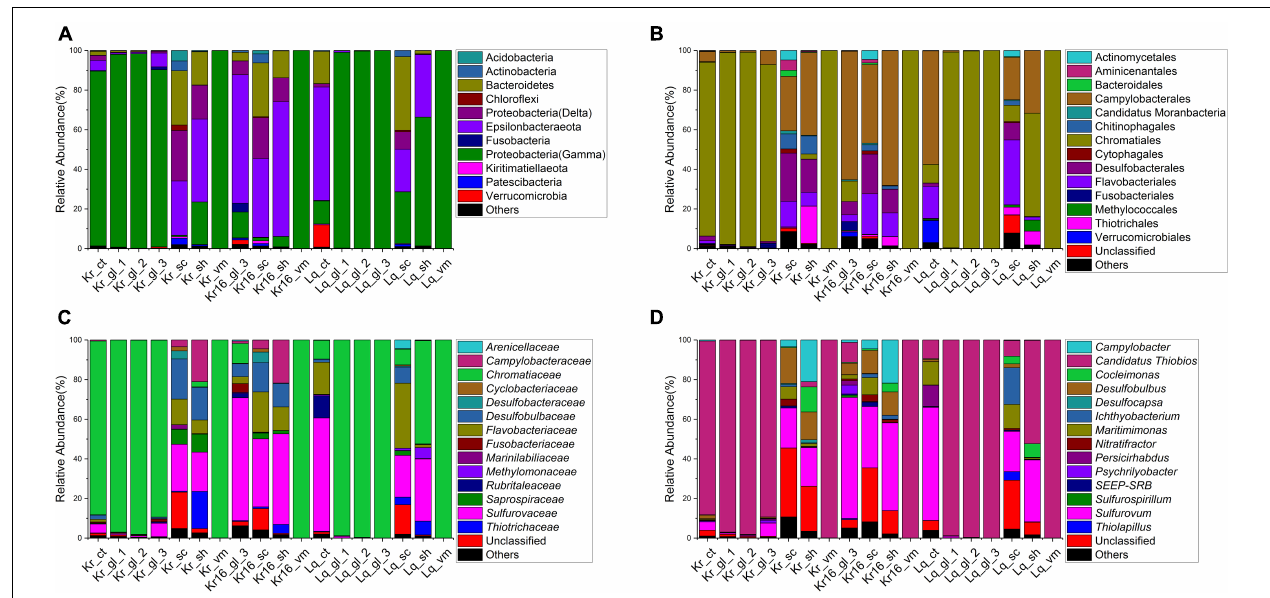
FIGURE 3 | Stacked bar chart showing the relative abundance of microbial communities from all samples at phylum and class levels (A) , order level (B) , family level (C) , and genus level (D) . The results based on the OTUs datasets.